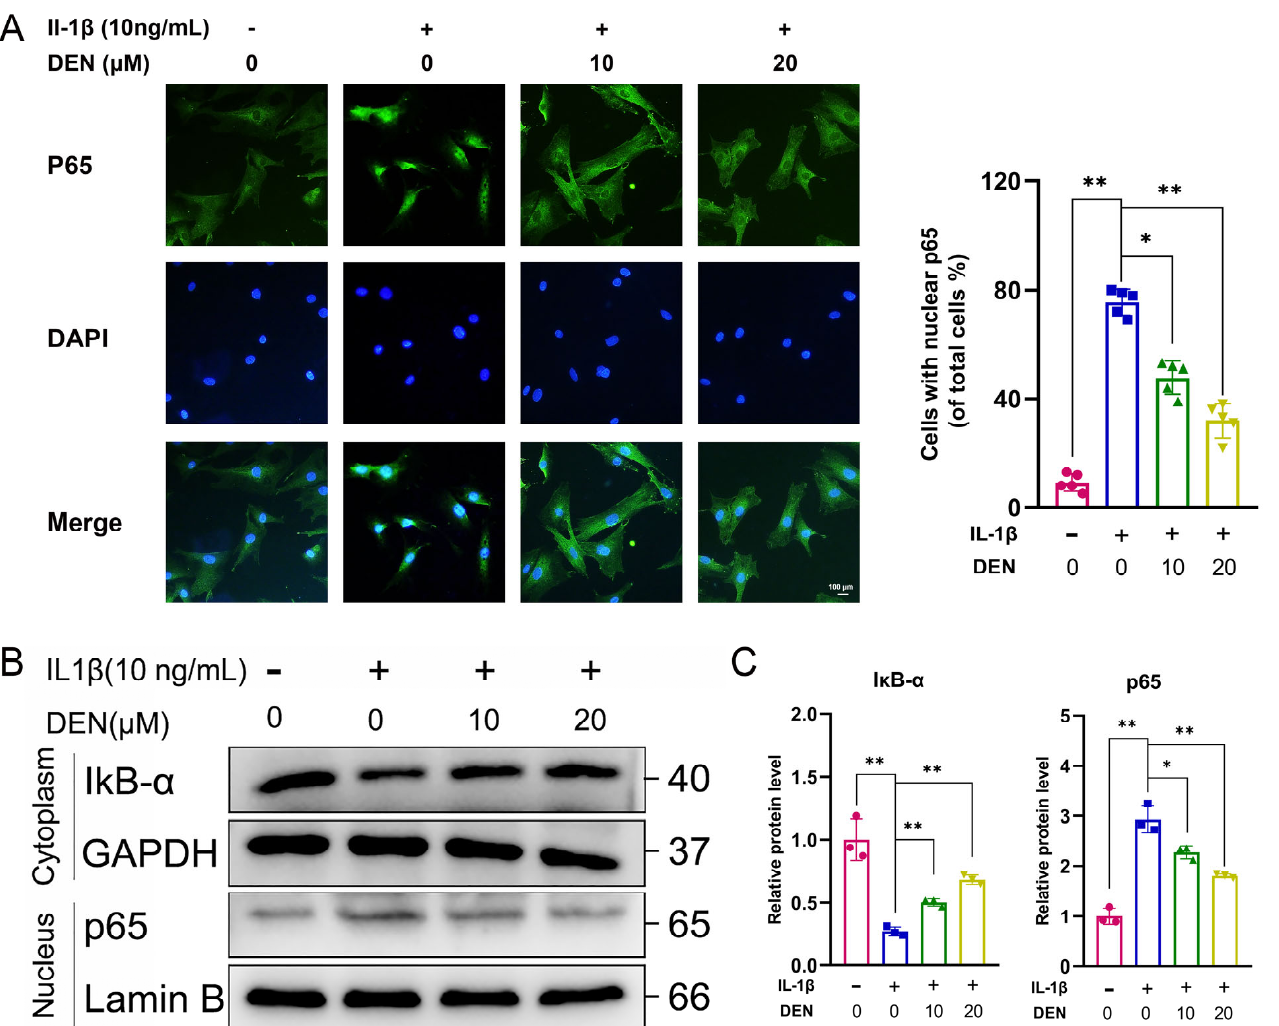
Figure 5. Effects of dendrobine (DEN) on the NF- κ B pathway in IL-1 β -treated chondrocytes. ( A ) The nuclear translocation of p65 was assessed by immunofluorescence staining, n = 5. ( B , C ) The protein levels of p65 in the nucleus and I κ B- α in the cytoplasm were presented by Western blotting, n = 3. The values presented are the means ± SD. * p < 0.05, ** p < 0.01.